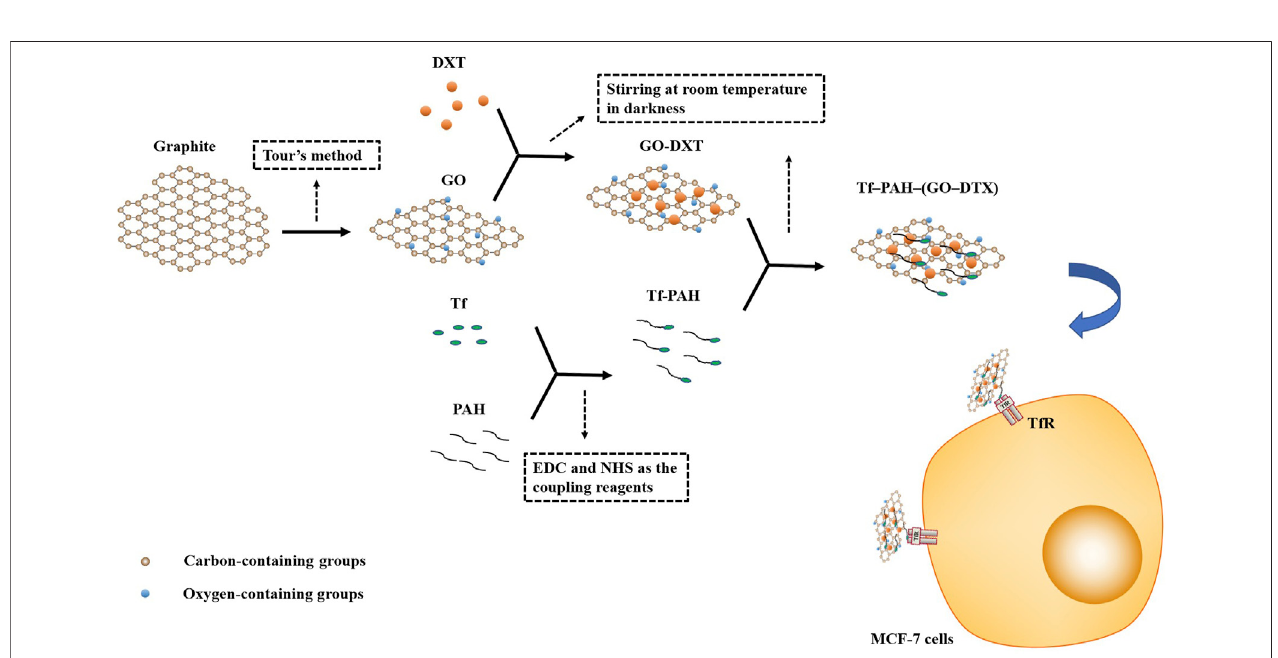
FIGURE 2 | Preparation of targeted GO. GO is prepared from graphite through the tour method. The mixture of GO and DXT was stirred for 24 h at room temperature in darkness to prepare GO-DXT. Tf-PAH is synthesized through the formation of amide linkages between COOH groups of Tf and NH2 groups of PAH throughEDCandNHSasthecouplingreagents.Tf-PAH-(GO-DTX)ispreparedbystirring themixtureofGO-DXTandTf-PAHfor10 hatroomtemperatureindarkness. Tf-PAH-(GO-DTX) could be taken up into MCF-7 cells by targeting TfR which would exert toxic effects.